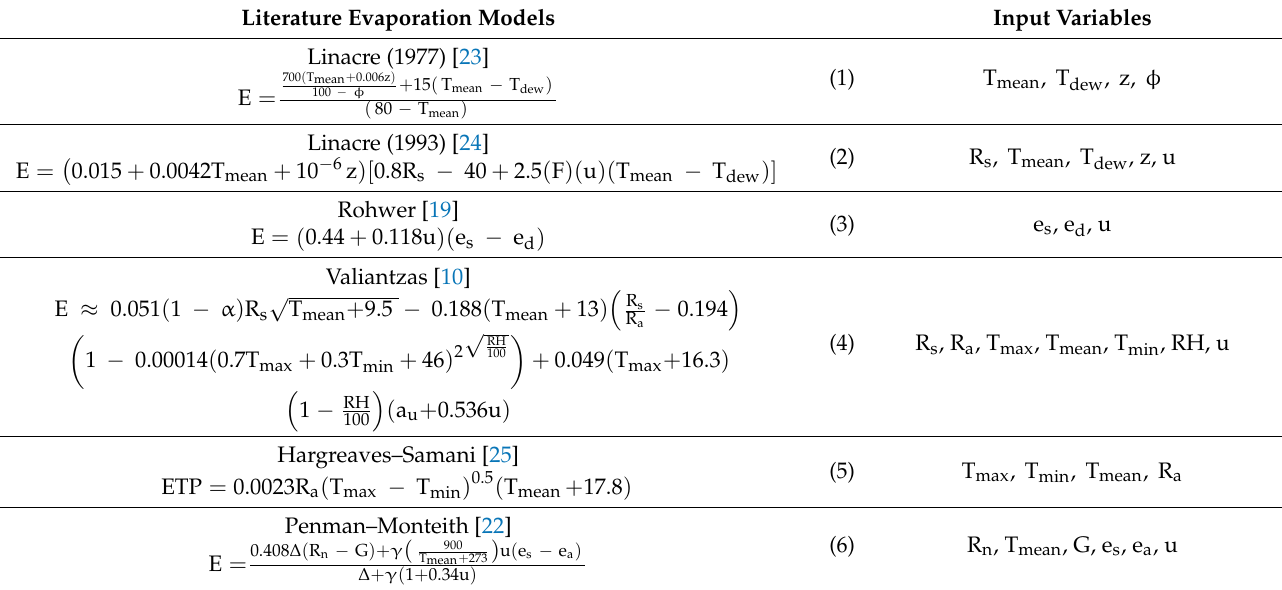
Table 1. Literature models for estimating the